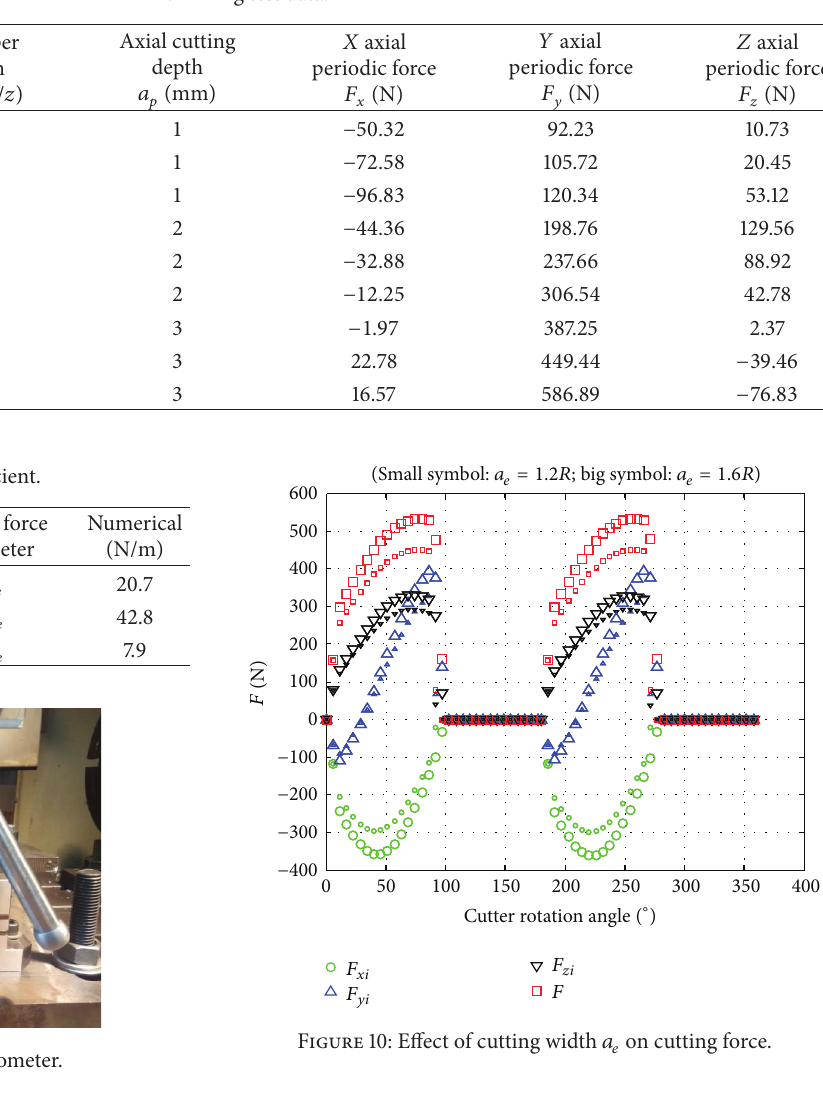
Table 2: Milling test data.